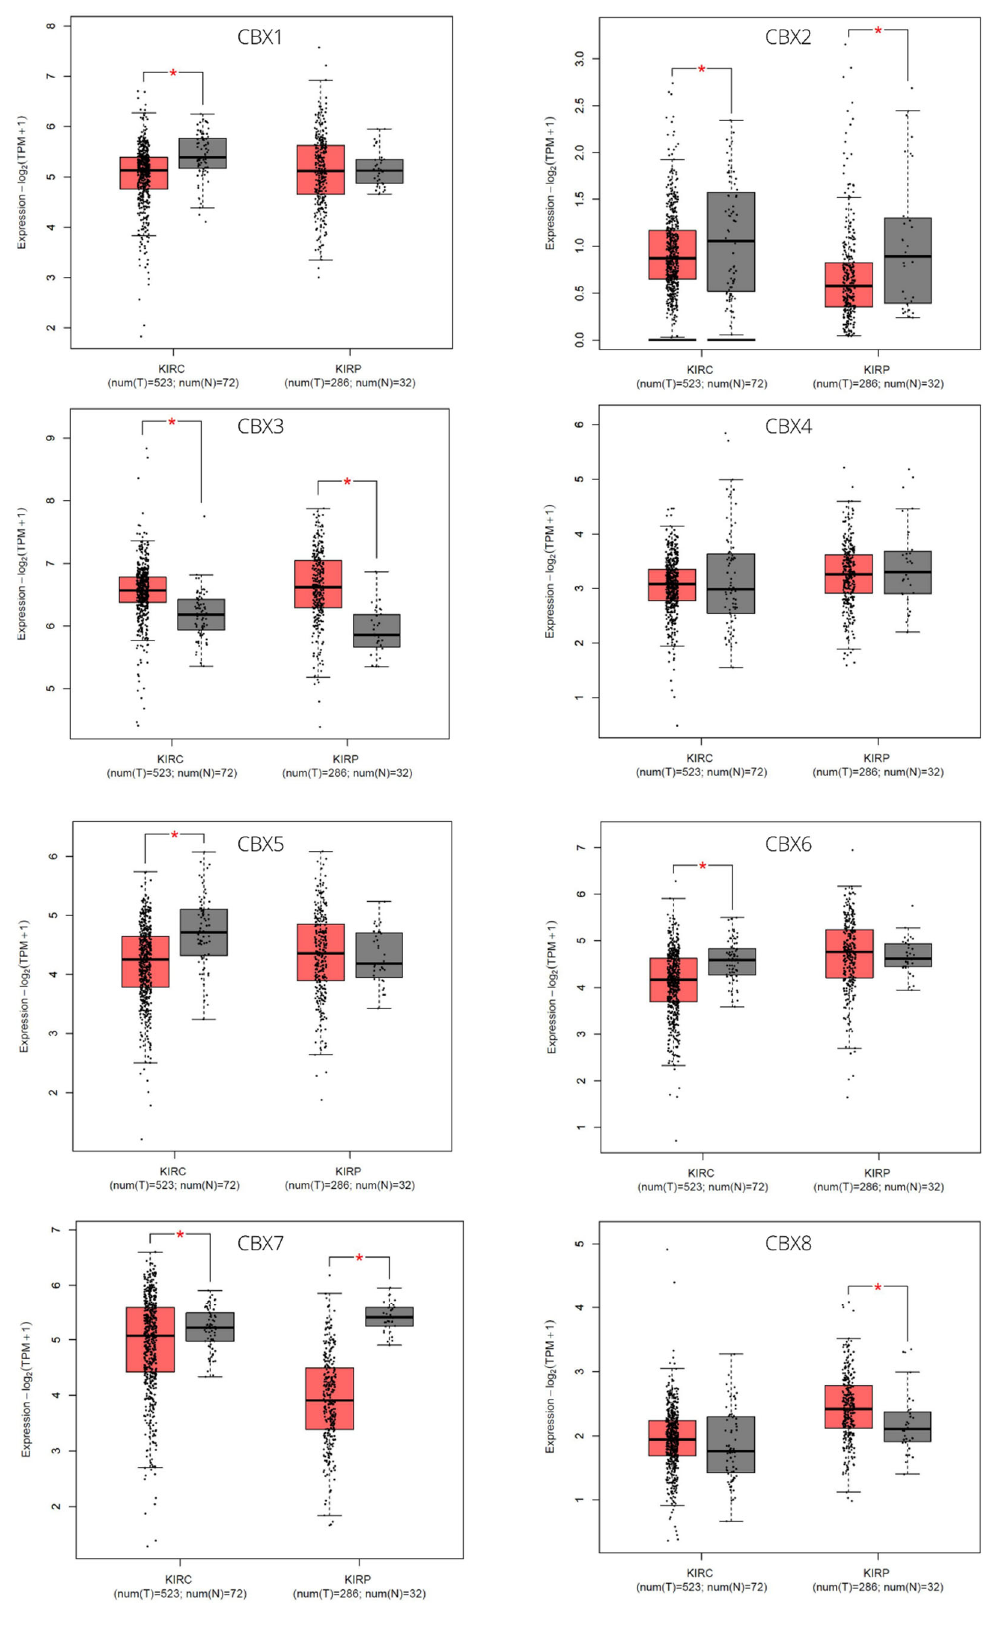
Figure 1. mRNA expression levels of CBX members in ccRCC (KIRC) and pRCC (KIRP) tissues and normal kidney tissues. *, p < 0.05. Analyses were performed using GEPIA2 * p < 0.05.